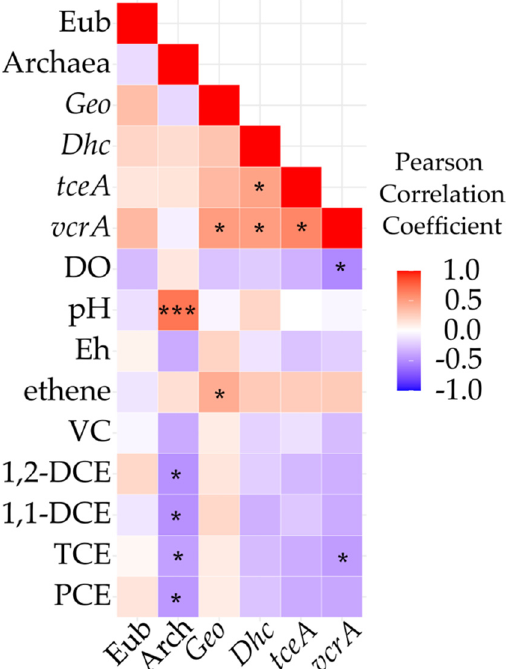
Figure 6. Pearson correlation indices among OHR biomarkers and physical-chemical parameters. Red shades indicate positive correlations and blue shades negative correlations. Asterisks indicates statistically significant correlations (* p ≤ 0.05 and *** p ≤ 0.001).